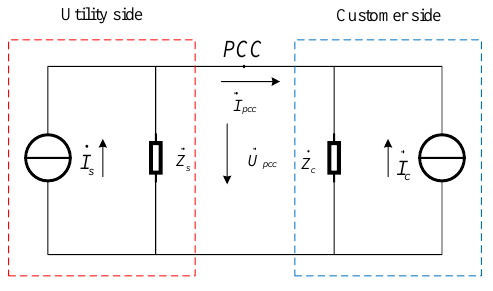
represent the represents the